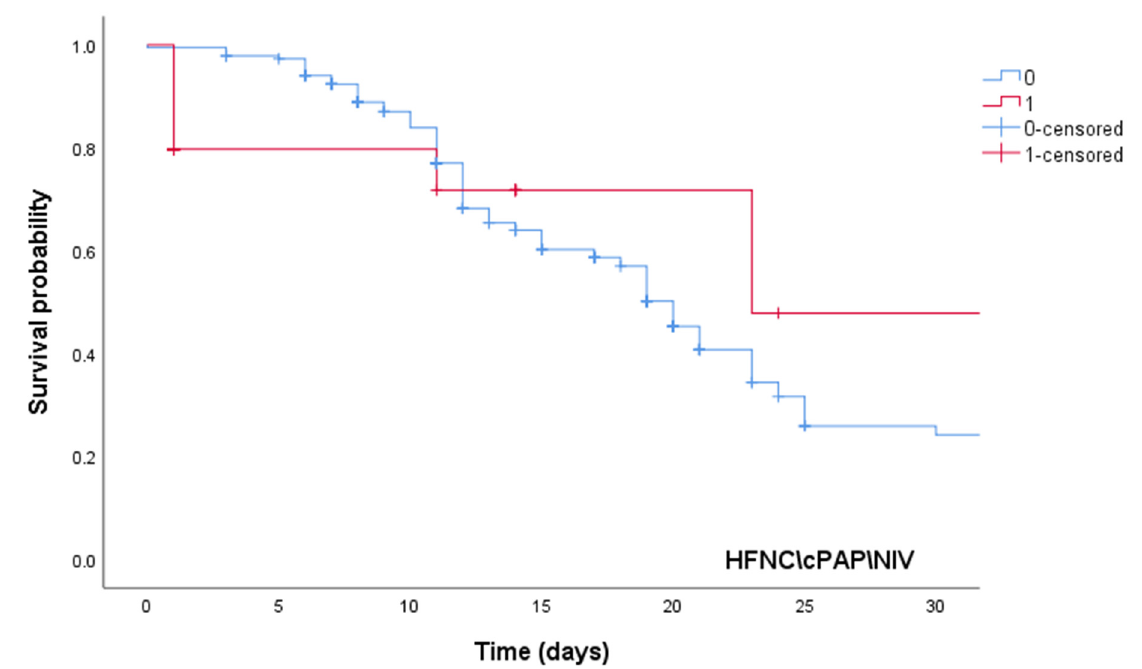
Figure 2. Kaplan–Meier curves of COVID-19 patients treated with high-dose steroid therapy (red line) or standard-dose steroid therapy (blue line) in the subgroups with no HFNC/CPAP/NIV use ( p = 0.457) or with HFNC/CPAP/NIV use ( p = 0.842). Legend. HFNC—high-flow nasal cannula; NIV—non-invasive ventilation; CPAP—continuous positive airway pressure.